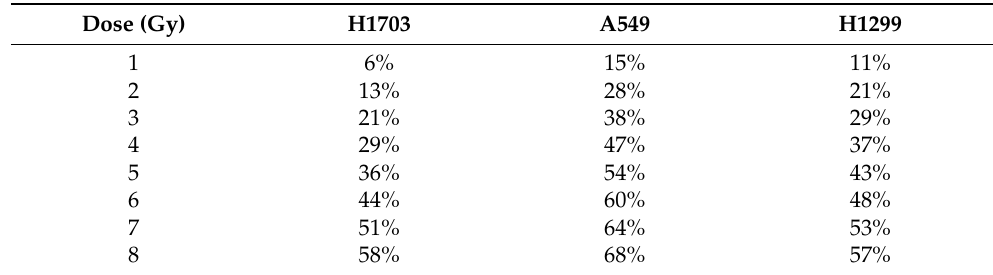
Table 3. Radiosensitizing effect of LY2874455 with D 10 or D 50 as the endpoint. Cell Line